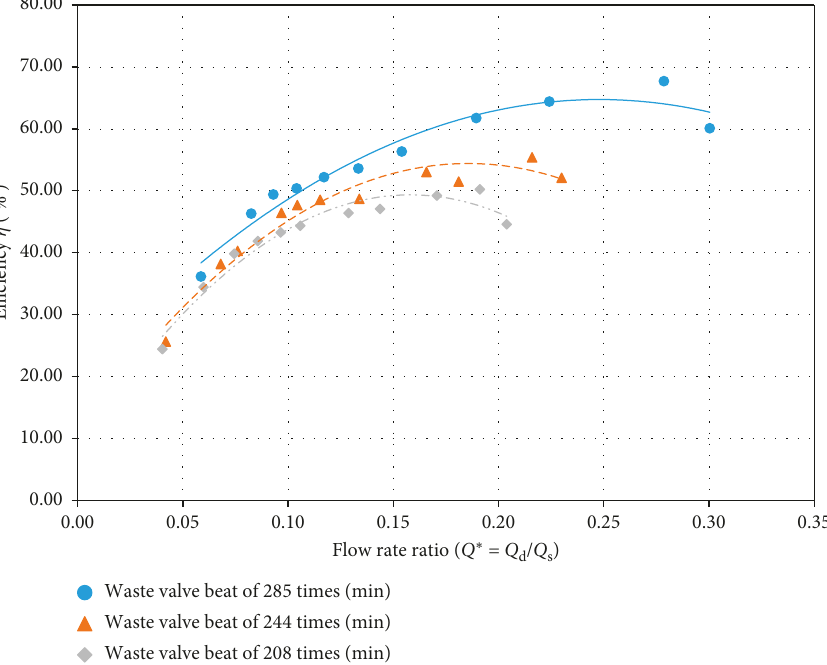
Figure 14: Efficiency vs. flow-rate ratio at different waste valve beat rates, f